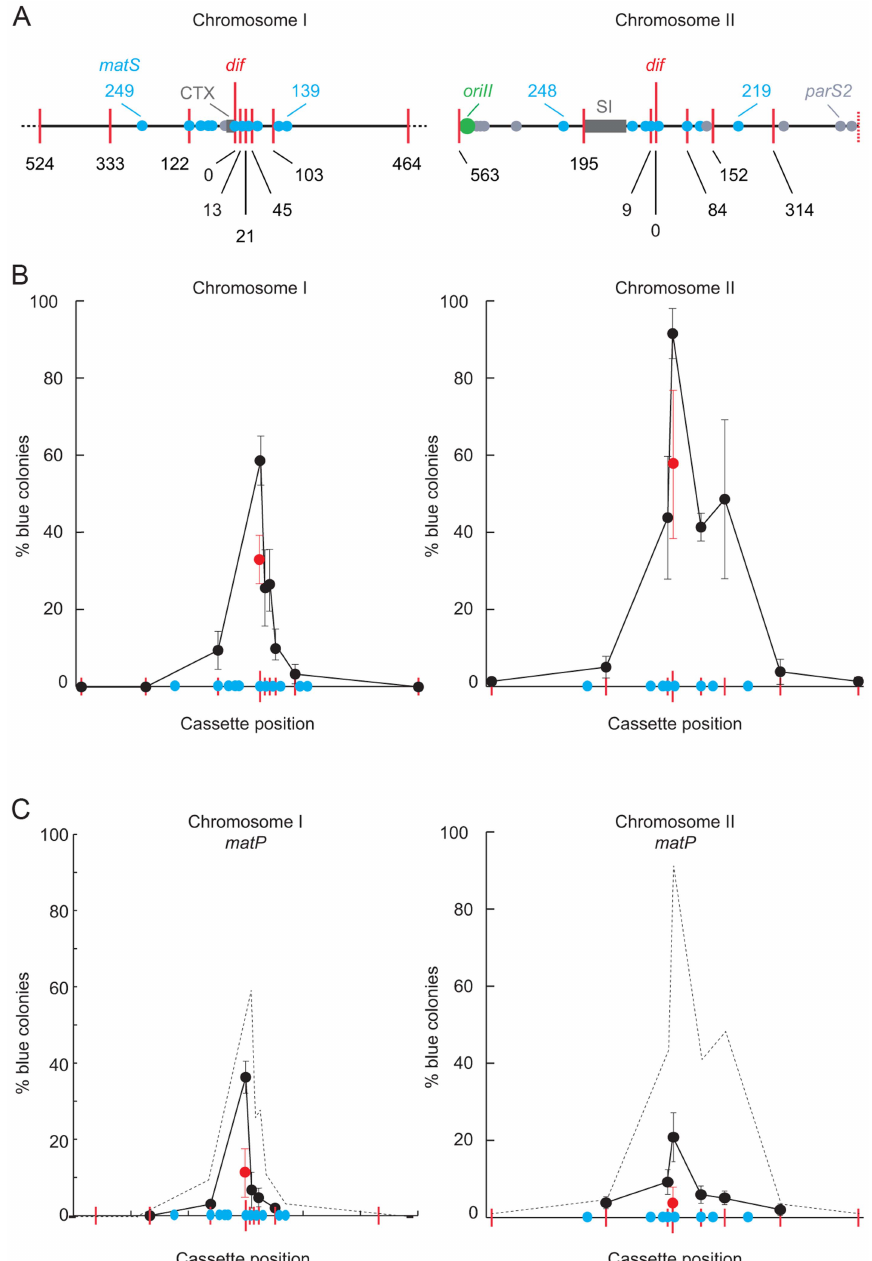
Figure 4. Influence of MatP on SCC during septation. A. V. cholerae chrI and chrII maps centred on their dif locus. Red bars: positions of lac2dif cassettes; blue disks: positions of matS sites; light grey disks: positions of parS2 sites; dark grey rectangle: recent chromosomal insertions (CTX: Integrative Mobile Elements Exploiting Xer; SI: superintegron). Only 1 Mbp of chrI is depicted. B. Relative frequency of SCC during septation as a function of the position of the distance from the dif locus (in kbp). Results from at least three independent experiments. C. Influence of MatP on sister chromatid contacts. Results from at least three independent experiments. The dashed grey curves show the results obtained in B.